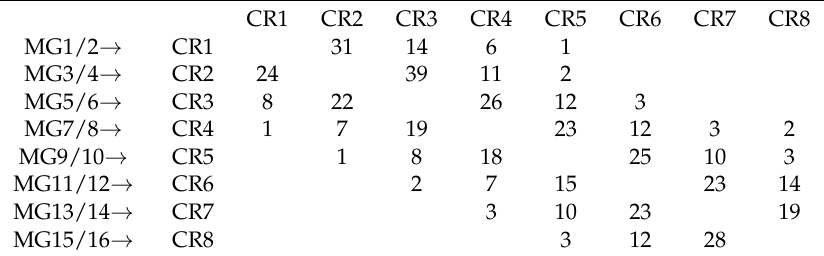
Table 1. Microgeneration (MG) accounting processes in the